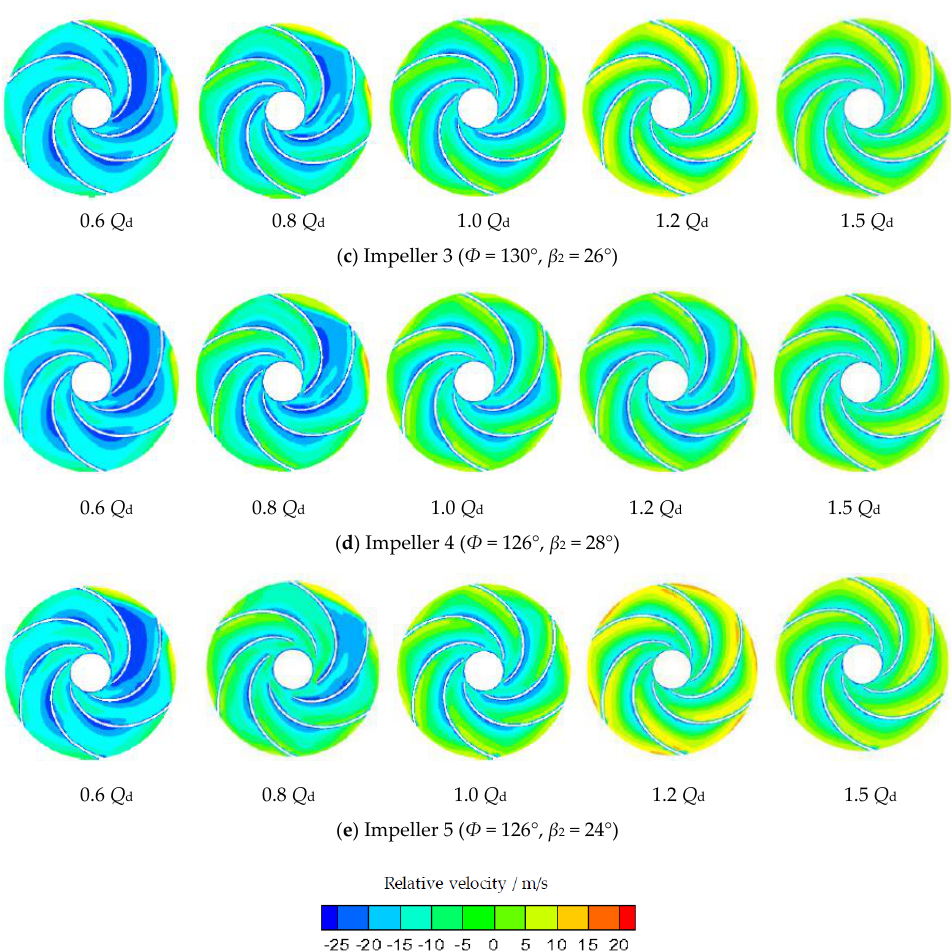
Figure 13. Variation of absolute velocity in different impellers.